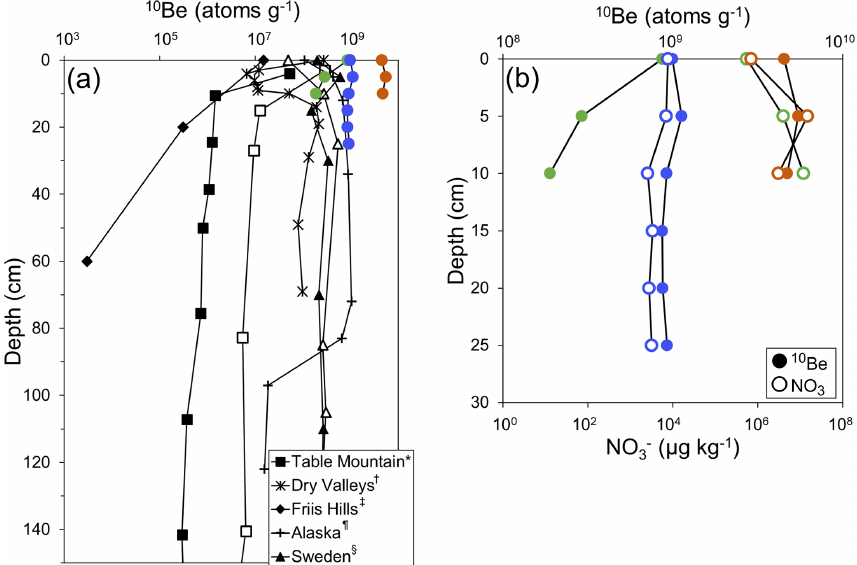
Figure 6. Soil profiles of meteoric 10 Be concentrations for Roberts Massif (orange), Bennett Platform (green), and Thanksgiving Valley (blue) compared to profiles from the Antarctic (Dickinson et al., 2012 ∗ ; Schiller et al., 2009 † ; Valletta et al., 2015 ‡ ) and Arctic (Bierman et al., 2014 § ; Ebert et al., 2012 ¶ ) (a) . The 10 Be concentration profiles were also compared to NO −